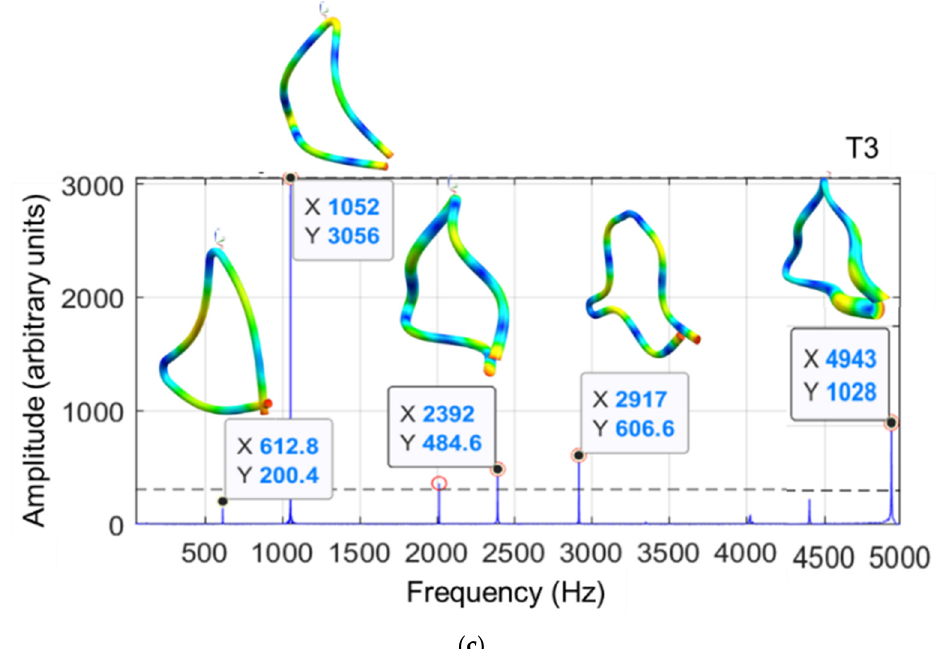
Figure 13. The corresponding modal shapes to experimental frequencies spectrum: ( a ) triangle T1; ( b ) triangle T2; ( c ) triangle T3.